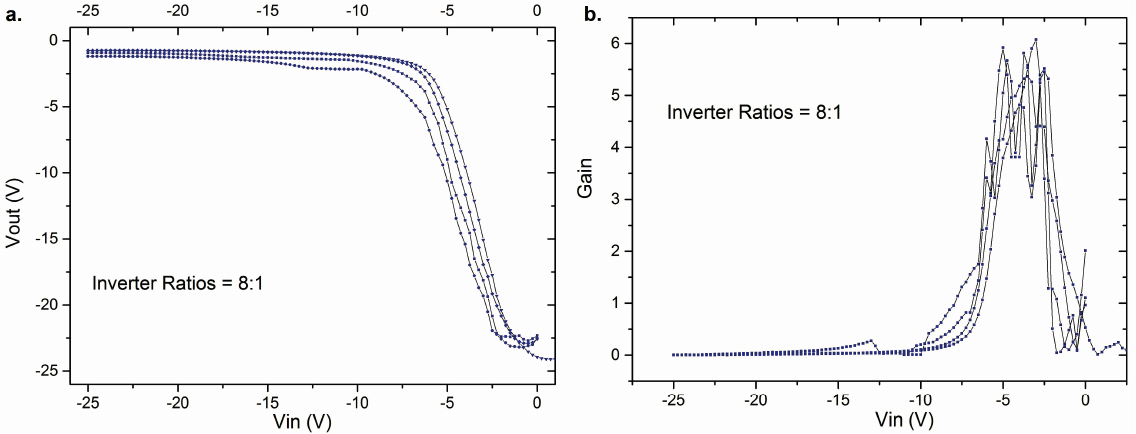
Figure 13. Graph indicating the low hysteresis in the transfer curves in ( a ) linear regime and in the ( b ) saturation regime.